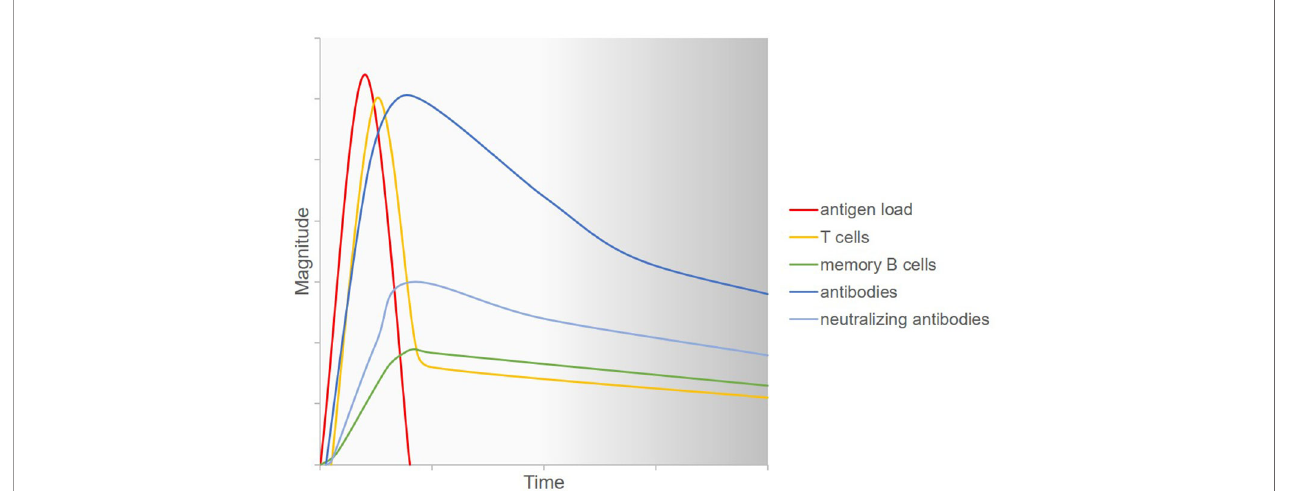
FIGURE 2 | Current understanding of the adaptive immune response to SARS-CoV-2 infection. Upon infection with SARS-CoV-2, the virus replicates in the human host and hence antigen load increases. Virus-speci fi c T cells are generated and fi ght the virus so that antigen load decreases. Simultaneously, B cells differentiate into plasma cells which produce antiviral antibodies. A part of the secreted antibodies have neutralizing capacities. Memory B cells emerge which can secrete speci fi c antibodies more rapidly upon rechallenge with the antigen. All of the aforementioned agents of the immune system decrease over time. However, the long-term kinetics of this decrease and the response to a possible repeated viral challenge at various time points are not known. Figure adapted with permission from (92,